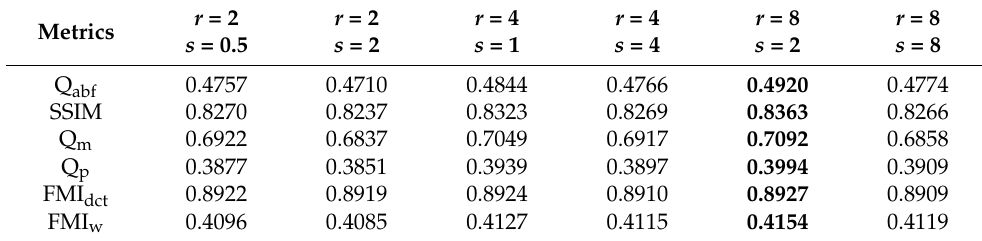
Table 3. Averages of the six metrics for different r and s values on ten pairs of source images from two public datasets. Numbers in bold font represent the best